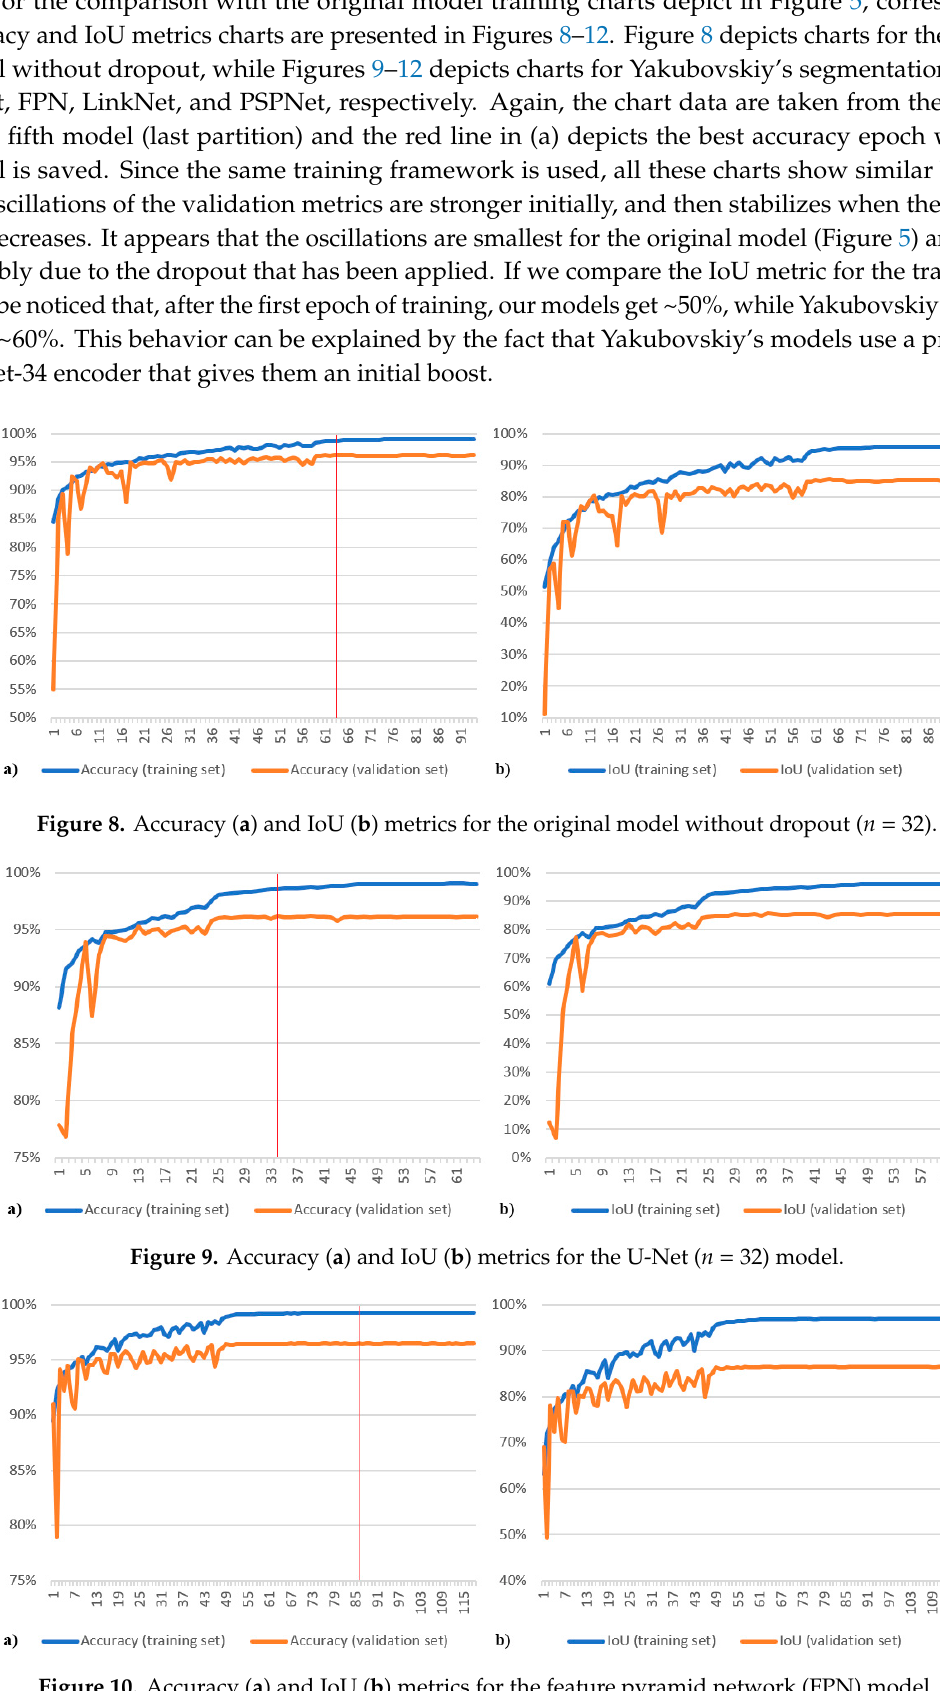
Figure 10. Accuracy ( a ) and IoU ( b ) metrics for the feature pyramid network (FPN) model.